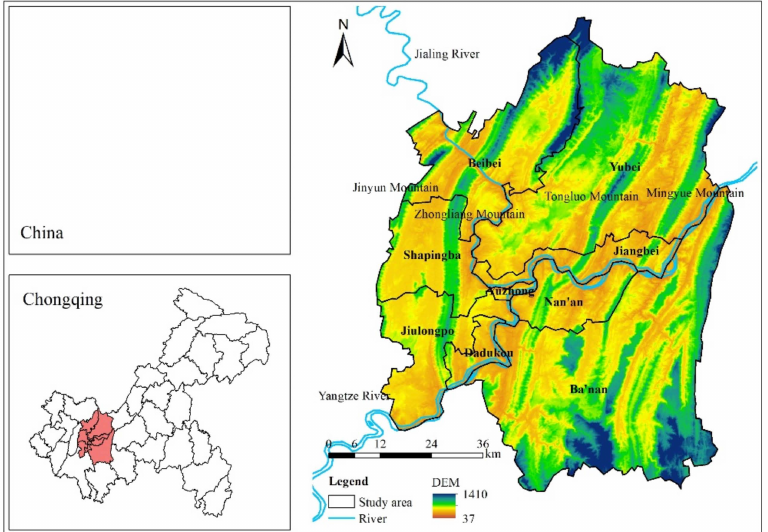
Figure 2. Study area.